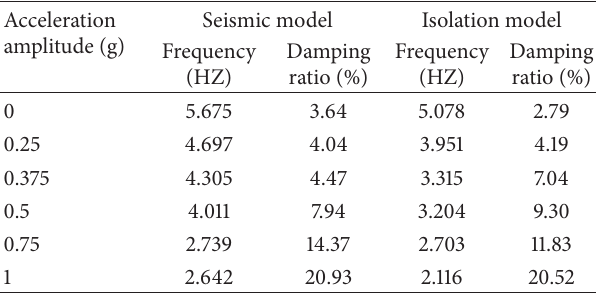
Table 4: Dynamic characteristics of the